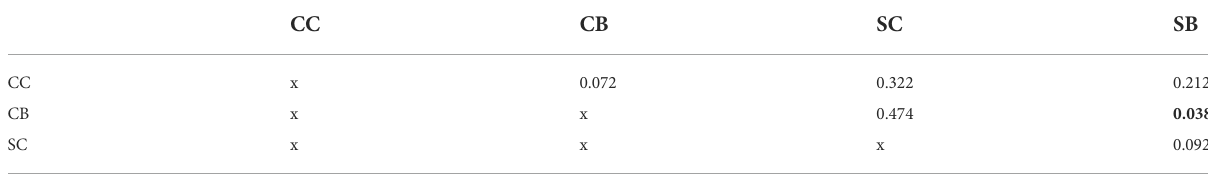
Table 4C: p -values for alpha band — post/pre